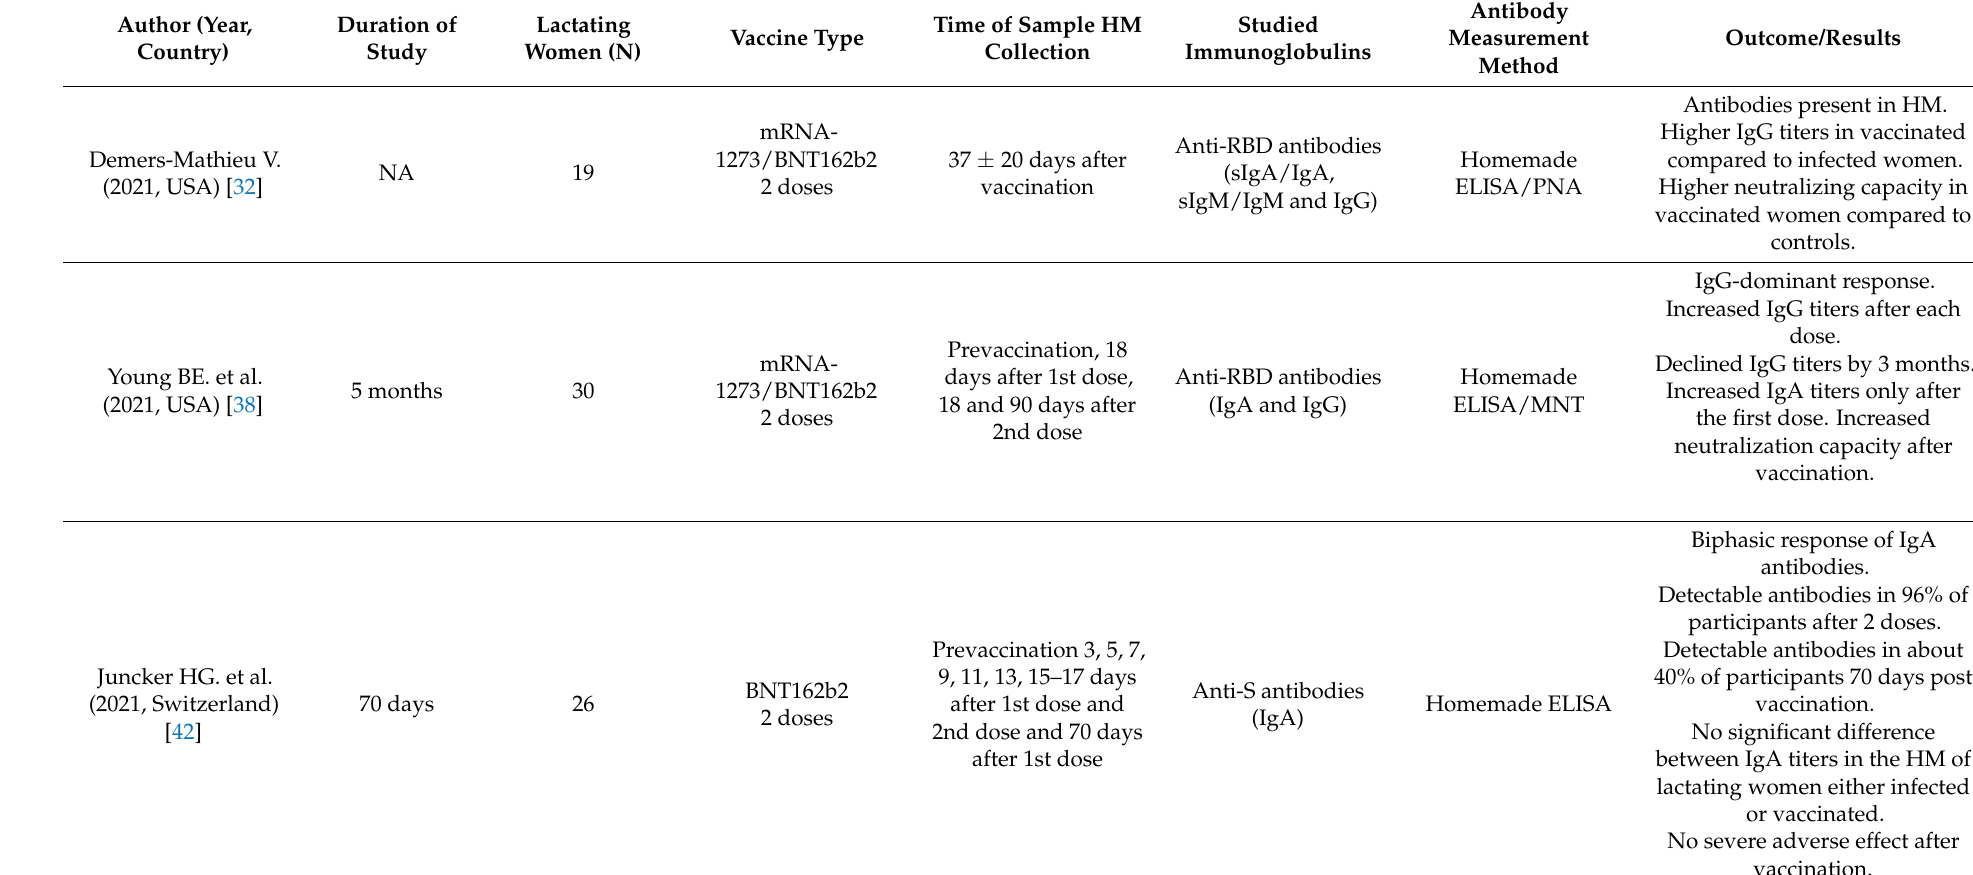
Table 4. Characteristics of included studies referring to vaccinated lactating women not previously infected or